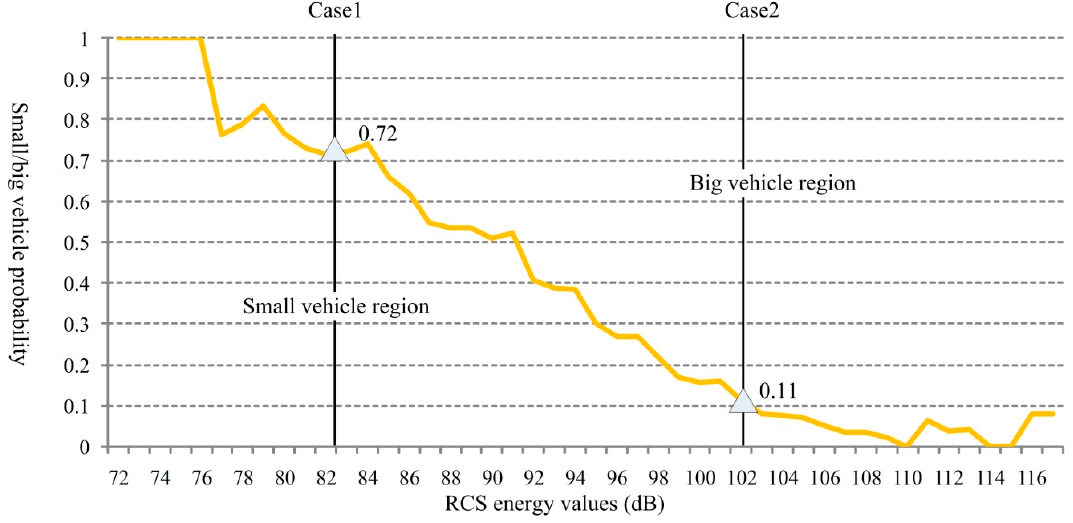
Figure 12. Vehicle type identification based on RCS energy values.